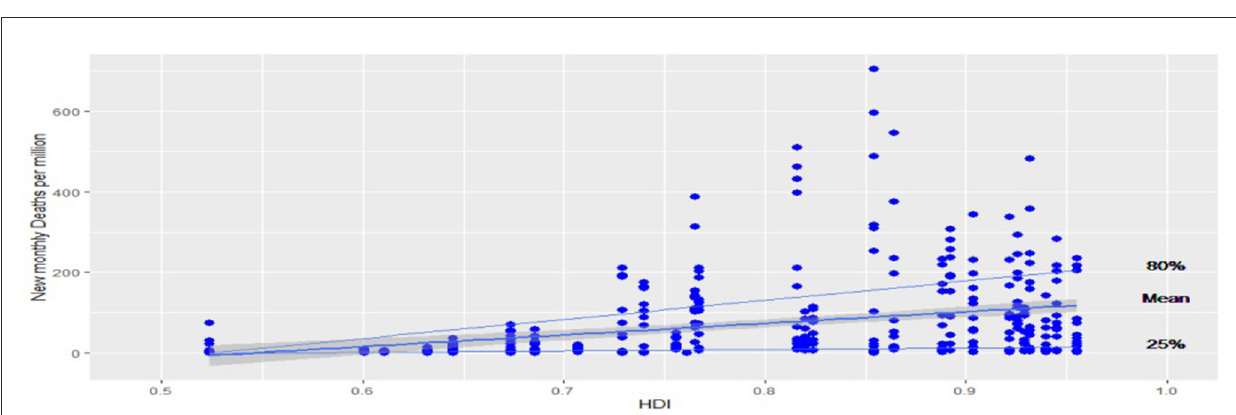
FIGURE6 Scatter plot between HDI and monthly new deaths; the lines represent the fitted quantile regressions at 25th percentiles, 80th percentiles, and the fitted mean